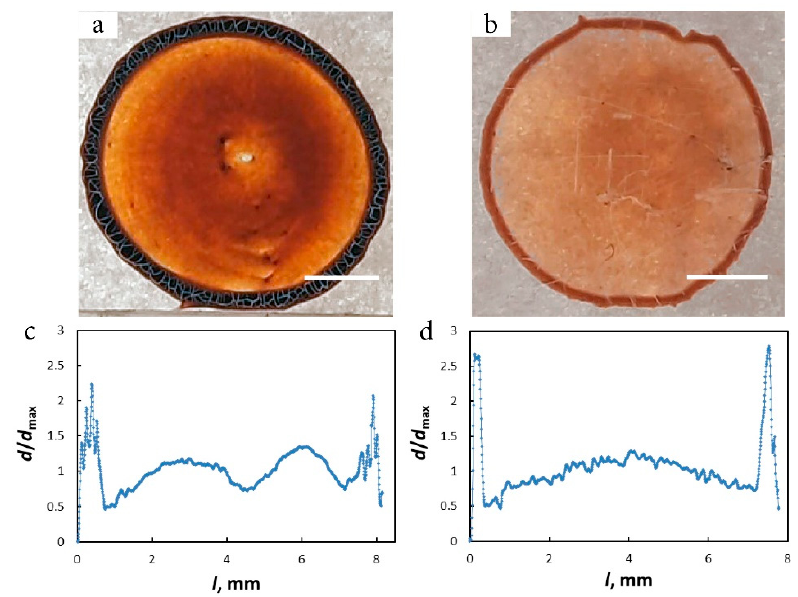
Figure 2. Visual appearance and relative thickness profiles of precipitates formed on a glass substrate after evaporation of sample drops No. 1 ( a , c ) and No. 2 ( b , d ). Scale bars are 2 mm.